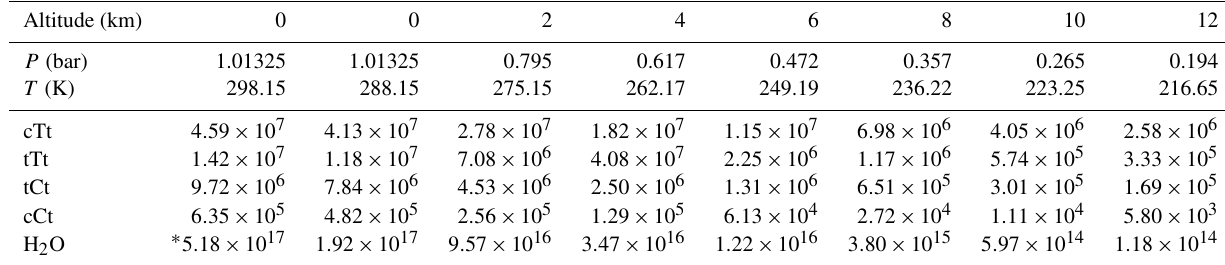
Table 4. Concentrations (in moleculescm − 3 ) of OA conformers involved in SO 3 hydration and water at different altitudes. Altitude (km)